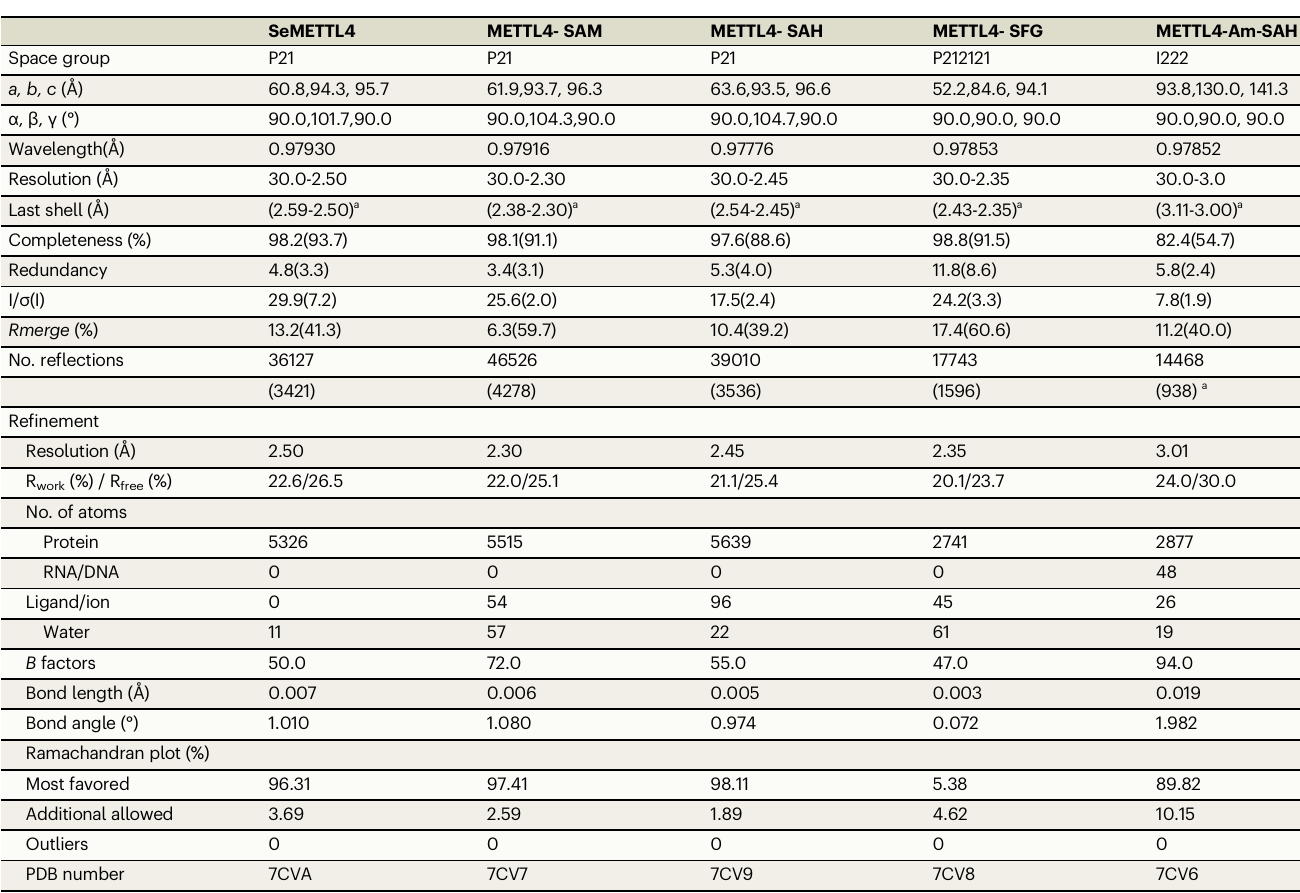
Table 2 | Data collection and re fi nement